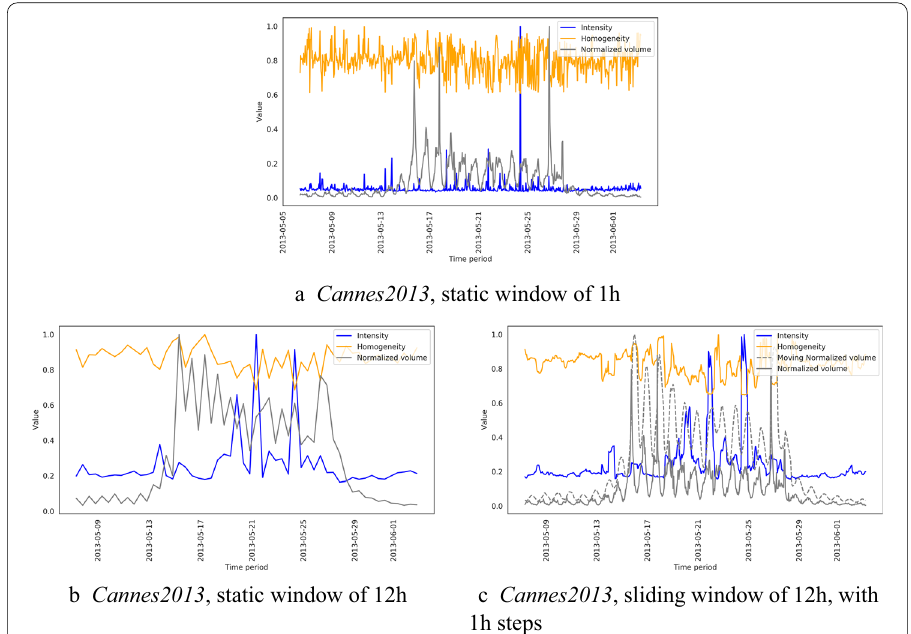
Fig. 18 Visualization of temporal entanglement across Cannes2013 . In grey, volume over the period of time (dotted line for the aggregated volume over sliding window ( c )). Intensity in blue and homogeneity in